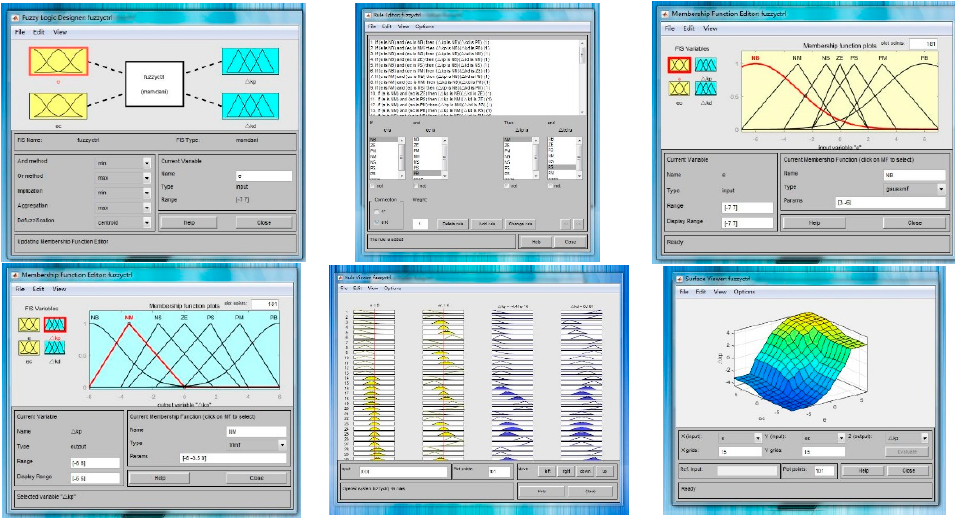
Figure 11. Fuzzy controller design.